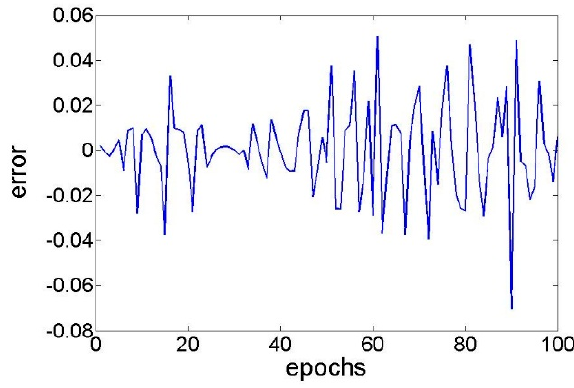
Figure 7. Fitting-error-rate curve for the original BP artificial neural network.